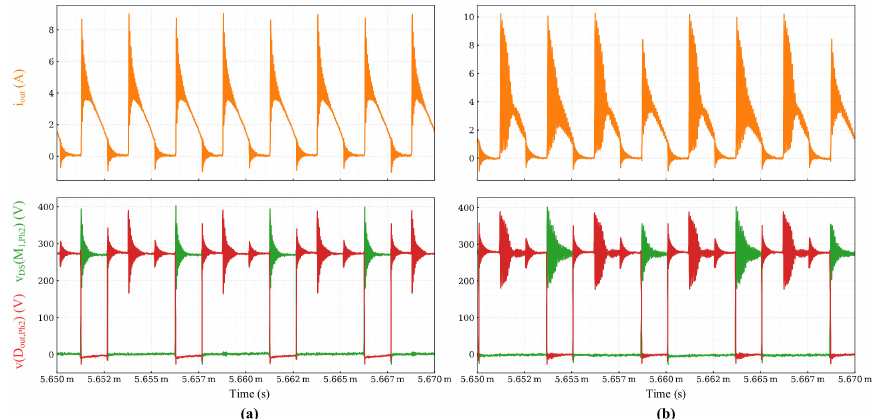
Figure 6. Converter waveforms: ( a ) SiC switch converter (SCT3120ALHR). Upper waveform: In orange current i out (2 A/div). Lower waveform: In green V DS (M 1,Ph2 ) (100 V/div); in red V(D out,Ph2 ) (100 V/div). Time scale 2.5 µ s/div. ( b ) GaN switch converter (TP65H035WSQA). Upper waveform: In orange current i out (2 A/div). Lower waveform: In green V DS (M 1,Ph2 ) (100 V/div); in red V(D out,Ph2 ) (100 V/div) Time scale 2.5 µ